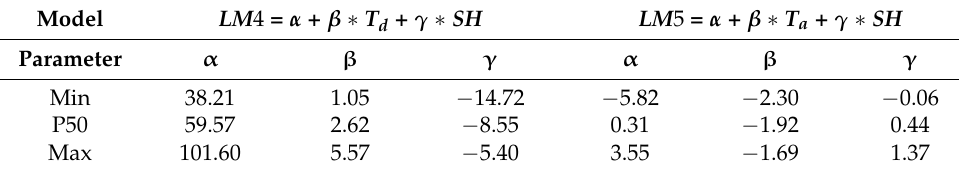
Table 8. Calibration of parameters for logistic models with predictors derived from RF. Model